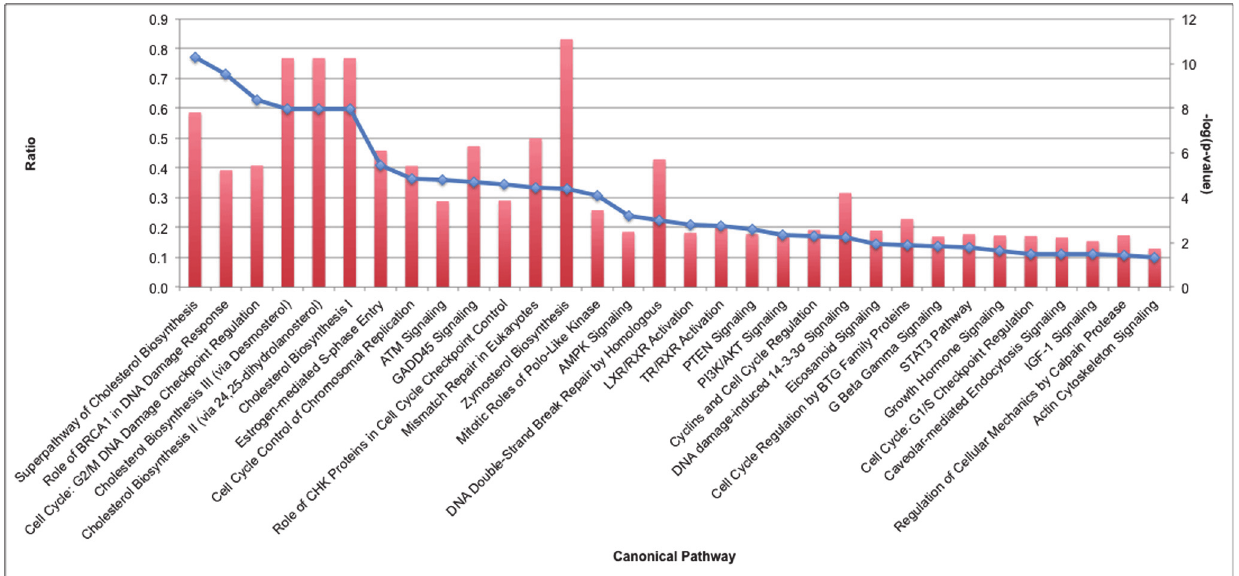
Fig 1. Cellular pathways with differential mRNA expression patterns in quadriceps muscle from Cfl2 KO mice compared to wild-type littermates. Results were graphed in order of decreasing log(p value), with the dot demonstrating the p-value corresponding to the right-sided y-axis. Ratio refers to the ratio of genes annotated in each pathway that are differentially expressed compared to the total number of genes annotated in the pathway, and is demonstrated by the bar corresponding to the left-sided y-axis.